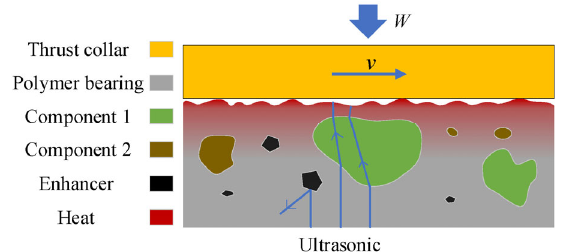
Fig. 2 Complex propagation phenomenon of ultrasonic waves in the non-uniform polymer